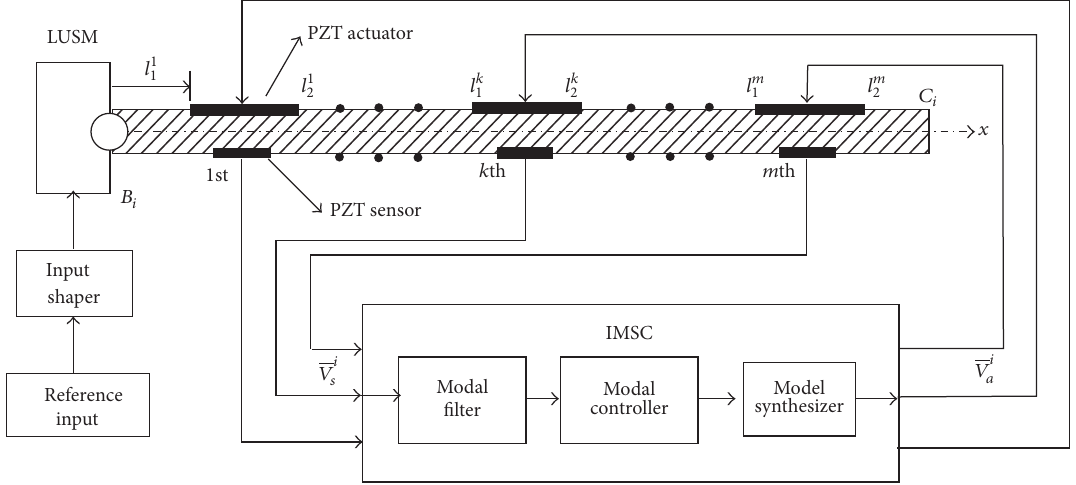
Figure 2: The proposed hybrid vibration control